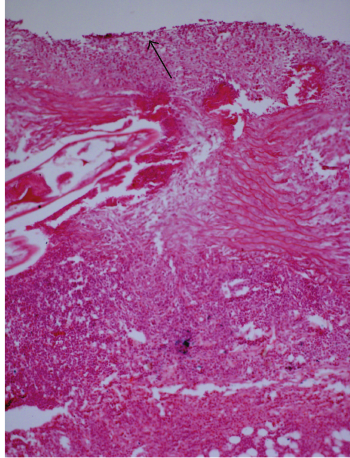
Figure 8: Section of aorta of a rabbit with a longitudinally cut section of S. lupi in media. Note the extensive tissue damage, necrotic debris in the parasitic tunnels/cavities, fragmented tunica elastica interna, and marked infiltration of inflammatory cells. Arrow indicates intima (H. E. original magnification × 100X).